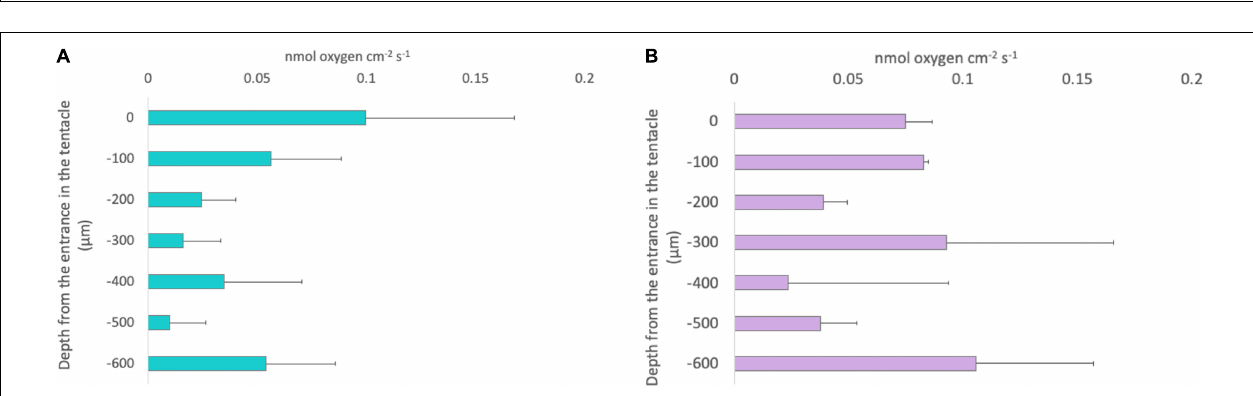
FIGURE 4 | Oxygen variations in the upper ∼ 1 mm of the oral arms of Cassiopea sp. during experimental light-dark shifts. Incident light was ∼ 1091 µ mol photons m − 2 s − 1 . The yellow rectangle indicates when the light where turned ON, whereas the gray rectangle indicates when the LEDs were turned OFF. In turquoise: the values obtained from three specimens collected during the afternoon. In lilac: the values obtained from three specimens collected at sunrise. The two distributions are significantly different (Mann-Whitney, p < 0.001; n = 3). Error bars represent the extreme values.